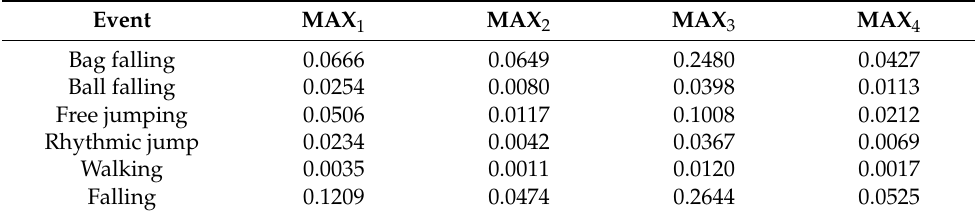
Table 2. Typical eigenvector at excitation position 1 of peak feature set.